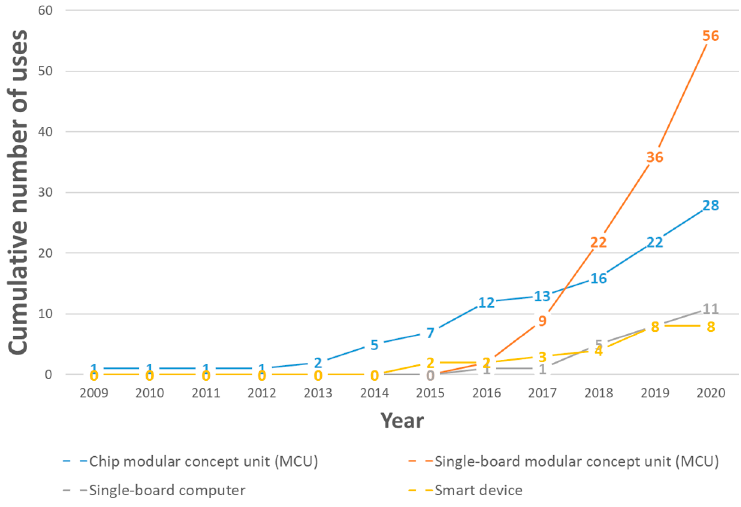
Figure 8. Cumulative number of microcontrollers used in smart helmet studies by year.